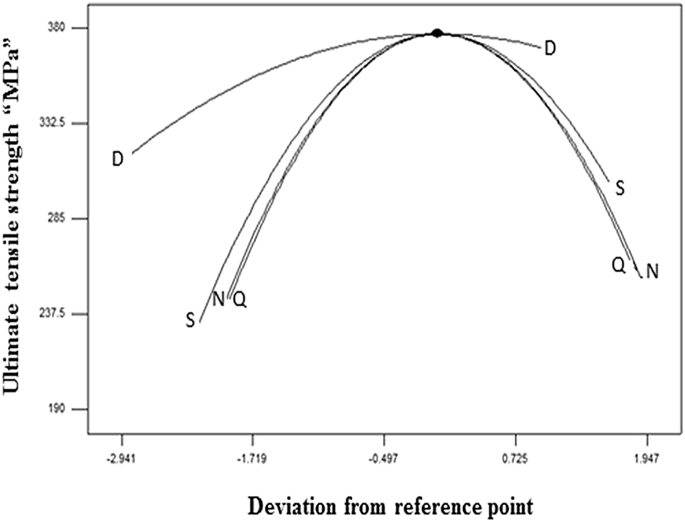
Perturbation graph.